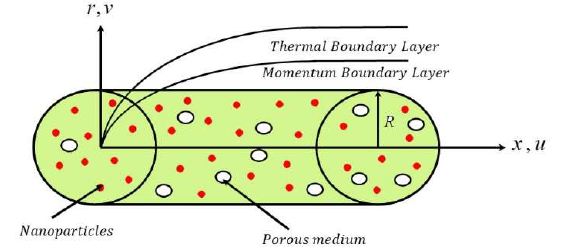
Figure 1 ). The x  axis of the cylinder is taken along the horizontal direction and the radial r  axis is taken normal or perpendicular to it. Further, assumed the surface xa U x  , where x  axis is measured along the surface of the velocity is denoted by   w L taken normal or perpendicular to it. Further, assumed the surface velocity is denoted by cylinder, L is the reference length and a is the positive stretching factor ( 0 a  ). The U w ( x ) = xa , where x − axis is measured along the surface of the cylinder, L is the reference impacts of melting and the porous medium were also included in the given model. In L length and a is the positive stretching factor ( a > 0). The impacts of melting and the porous addition, u and v denoted the velocity components along the respective and axes medium were also included in the given model. In addition, u and v denoted the velocity and denoted the temperature of the fluid. Momentum and heat analyses were carried components along the respective x and r axes and T denoted the temperature of the fluid. out for both the fluid and dust phases. Momentum and heat analyses were carried out for both the fluid and dust phases.